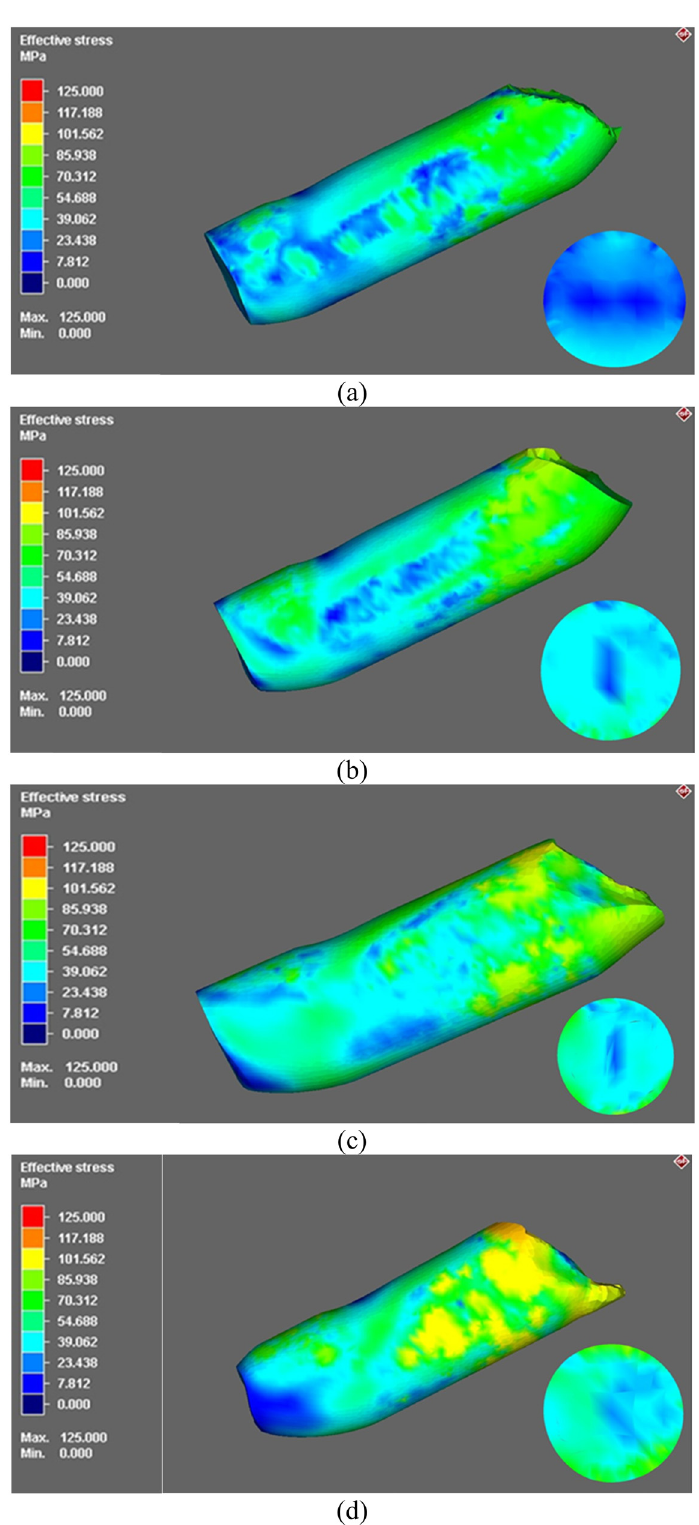
Figure 4: Stress distribution along both the LS and TS of the Cu billets processed through ECAP using the 120° - die through 1 - P ( a ) , 2 - Bc ( b ) , 3 - Bc ( c ) , and 4 - Bc ( d )